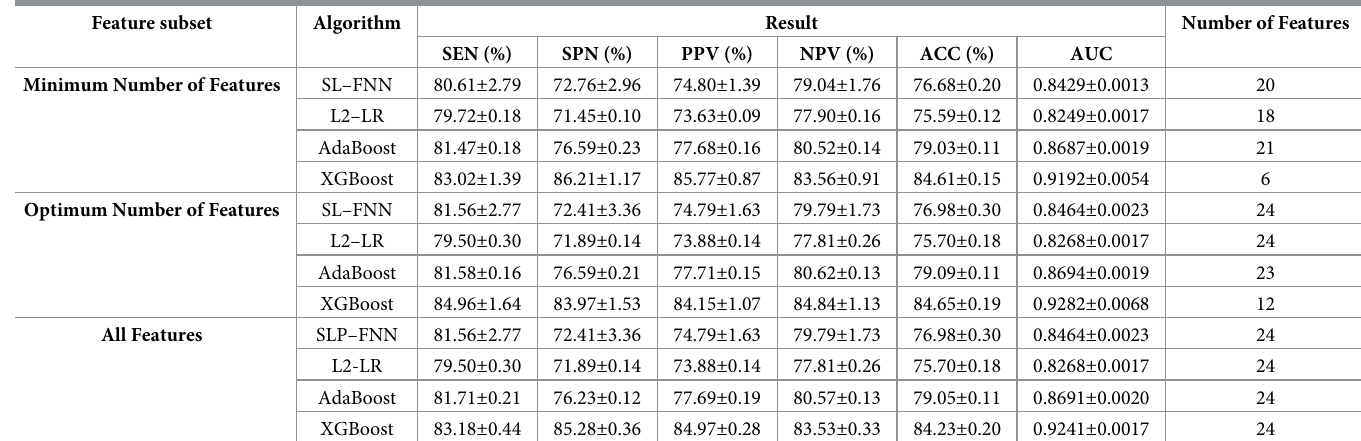
Table 5. Identification results of the four algorithms on the training set for different feature subsets.